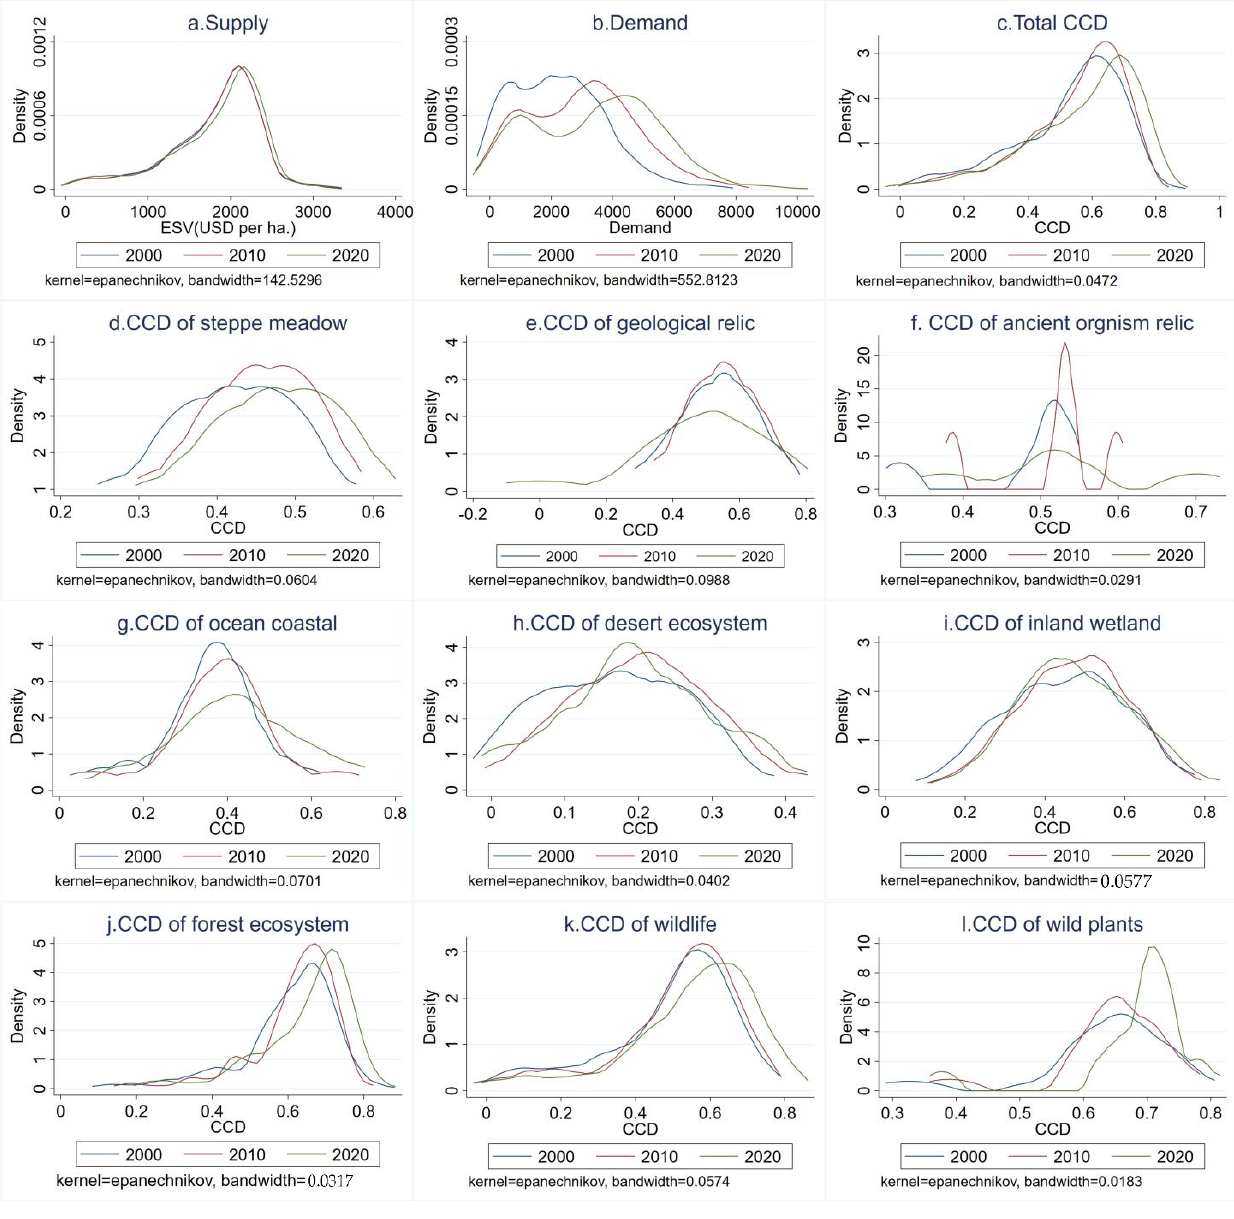
Figure 7. Kernel density estimation of ecosystem services supply – demand coupling coordination degree in different types of nature reserves from 2000 to 2020.